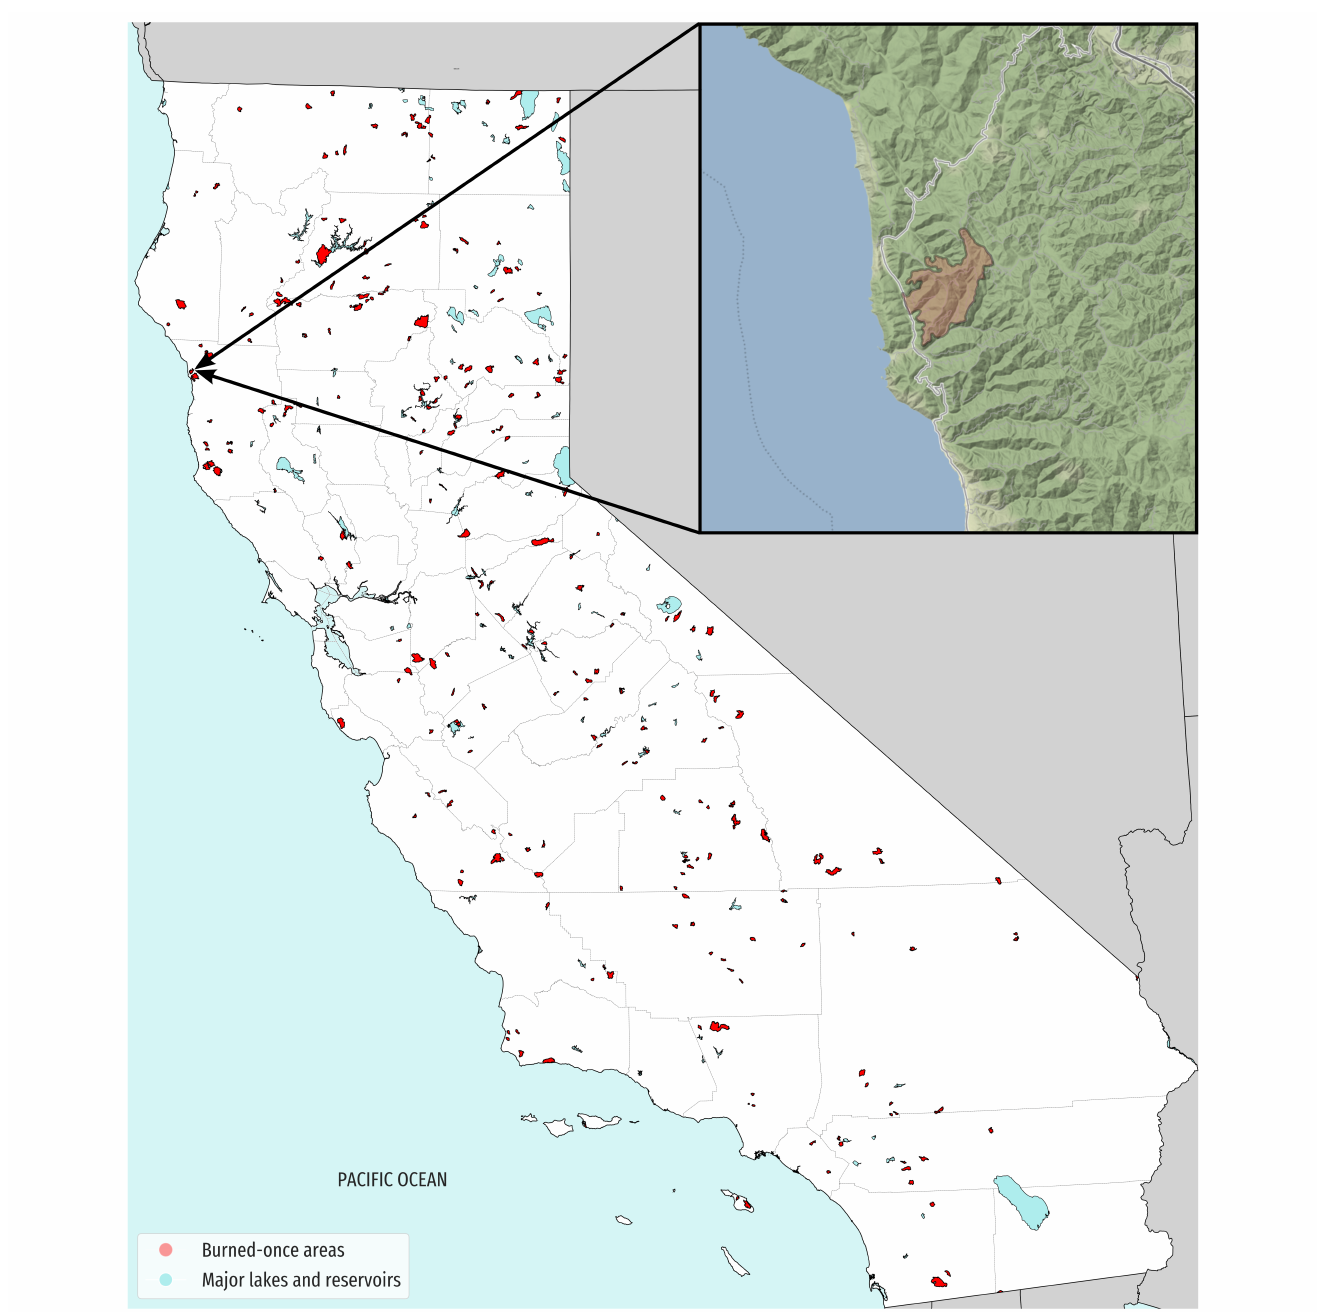
Figure 1. Map of California and the perimeters selected for this study. The upper right corner shows the perimeter of the MEU LIGHTNING COMPLEX (MIDDLE) wildfire in June 2008. The figure was generated using geopandas [27], and the data of the polygons was obtained from the Monitoring Trends in Burn Severity (MTBS) program [24], and polygons of the state and major lakes and reservoirs were obtained form the California Open Data Portal https://data.ca.gov (accessed on 6 April 2020). The top right-hand side picture was created with the contextily Python package https://contextily.readthedocs. io/en/latest/ (accessed on 20 April 2021), using the Map tiles by Stamen Deisgn, CC BY 3.0—Map data (C) OpenStreetMap